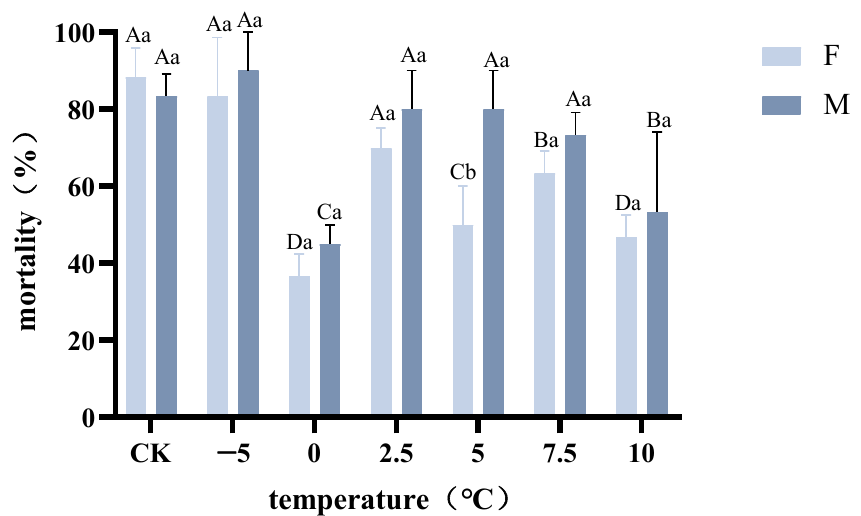
Figure 2. Effects of rapid cold hardening on the mortality of adult Agasicles hygrophila . We used repeated-measures ANOVA, followed by the LSD test ( p < 0.05). Capital letters refer to the differences in the mortality of A. hygrophila following treatment with the same temperature for the different sexes. Lowercase letters refer to the differences in the mortality of A. hygrophila following treatment with different temperatures for the same gender of different temperature RCH. All values are presented as the mean ± SE.